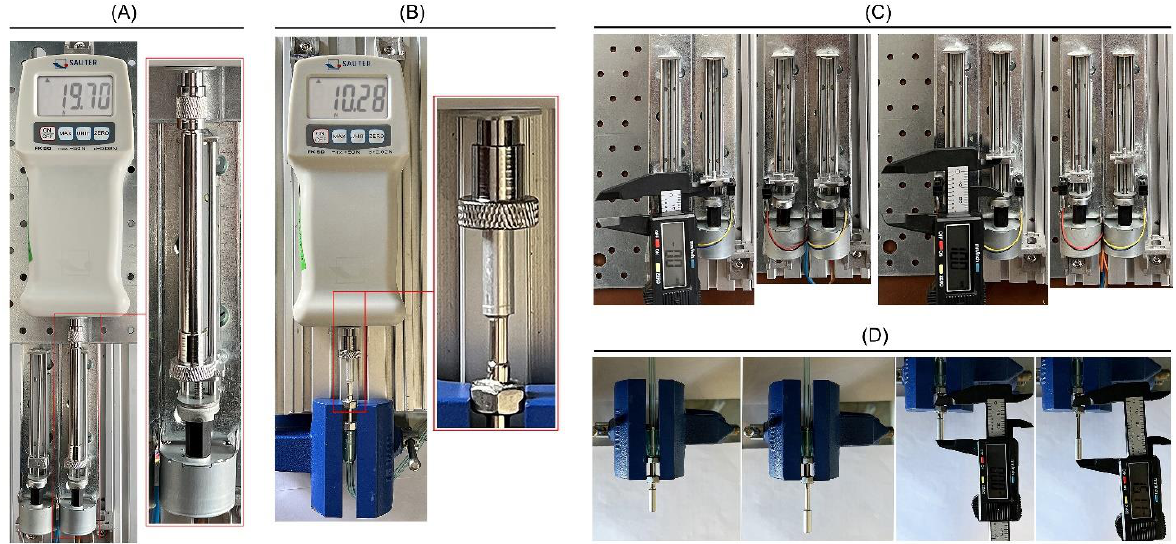
Figure 11. The experimental tests: ( A ) measuring the generated pushing force via linear mechanism; ( B ) measuring the transmitted force (i.e., DF); ( C ) linear positioning of the carriage of the linear mechanism; ( D ) linear positioning of the end effector. Table 1. Measurement of the linear positioning and the generated force.